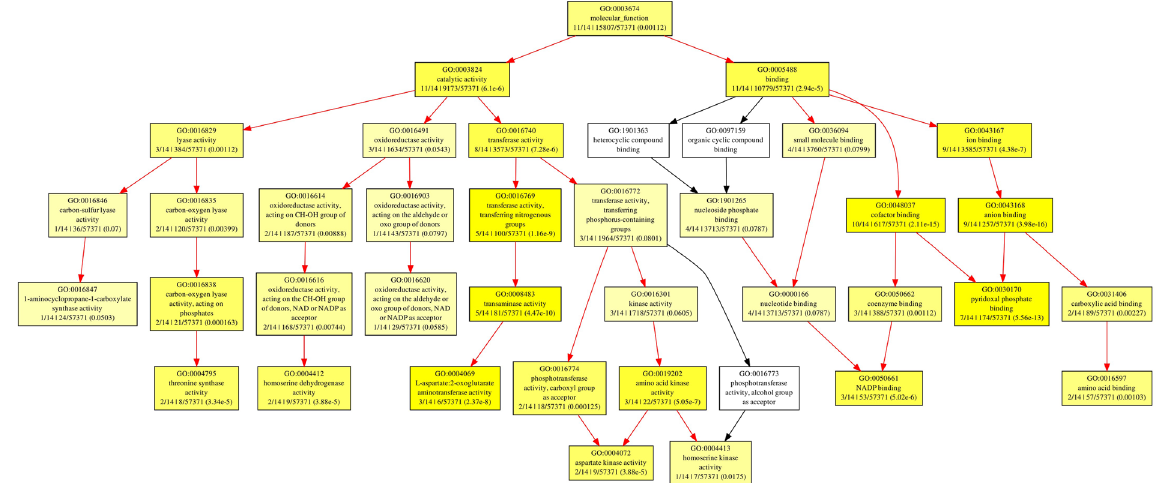
Figure 9. Classification of AbSR -ThrMPG based on their molecular function. Boxes represent GO terms, term definition, labelled by its GO ID, and detailed information, organized as ‘q/m|t/k ( P -value)’ (‘q/m|t/k’- GO term enrichment analysis values calculated by Fisher’s exact test. The GO enrichment analysis formula adopted from Zheng and Wang, 2008). Yellow color boxes indicate significantly enriched GO terms. The level of color saturation of each node is positively correlated to the significant level of the corresponding GO term. White color boxes represent non – significant GO terms within the hierarchical tree. Arrows signify the connections between different GO terms. Red color arrows indicates relationships between two enriched GO terms, black color arrows represent relationships between enriched and un-enriched GO terms.